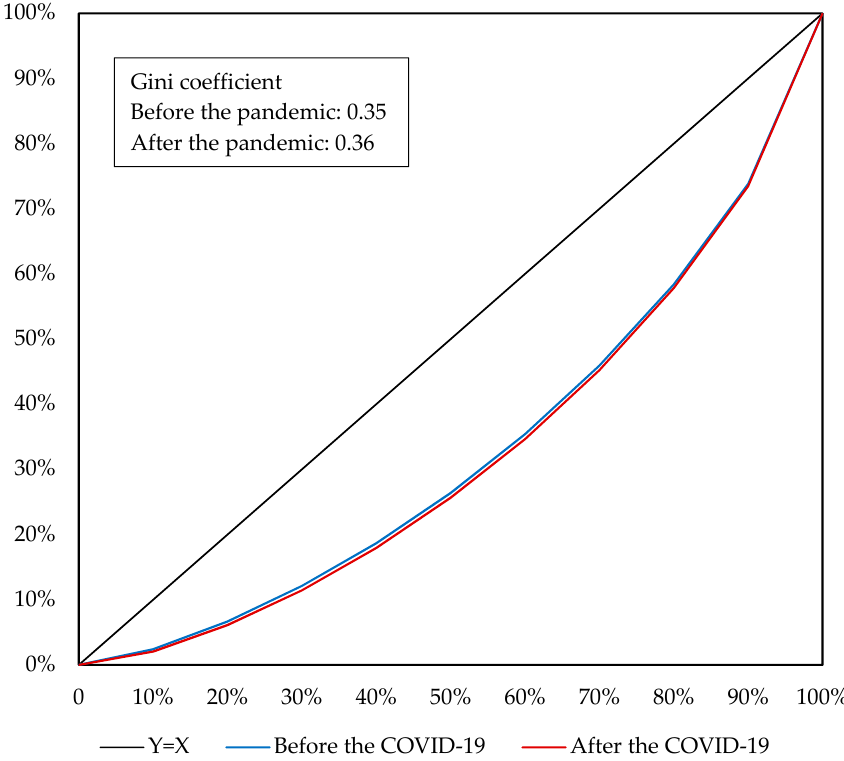
Figure 8. Lorentz curve of urban residents before and after the COVID-19 pandemic. Source: Author’s calculation.